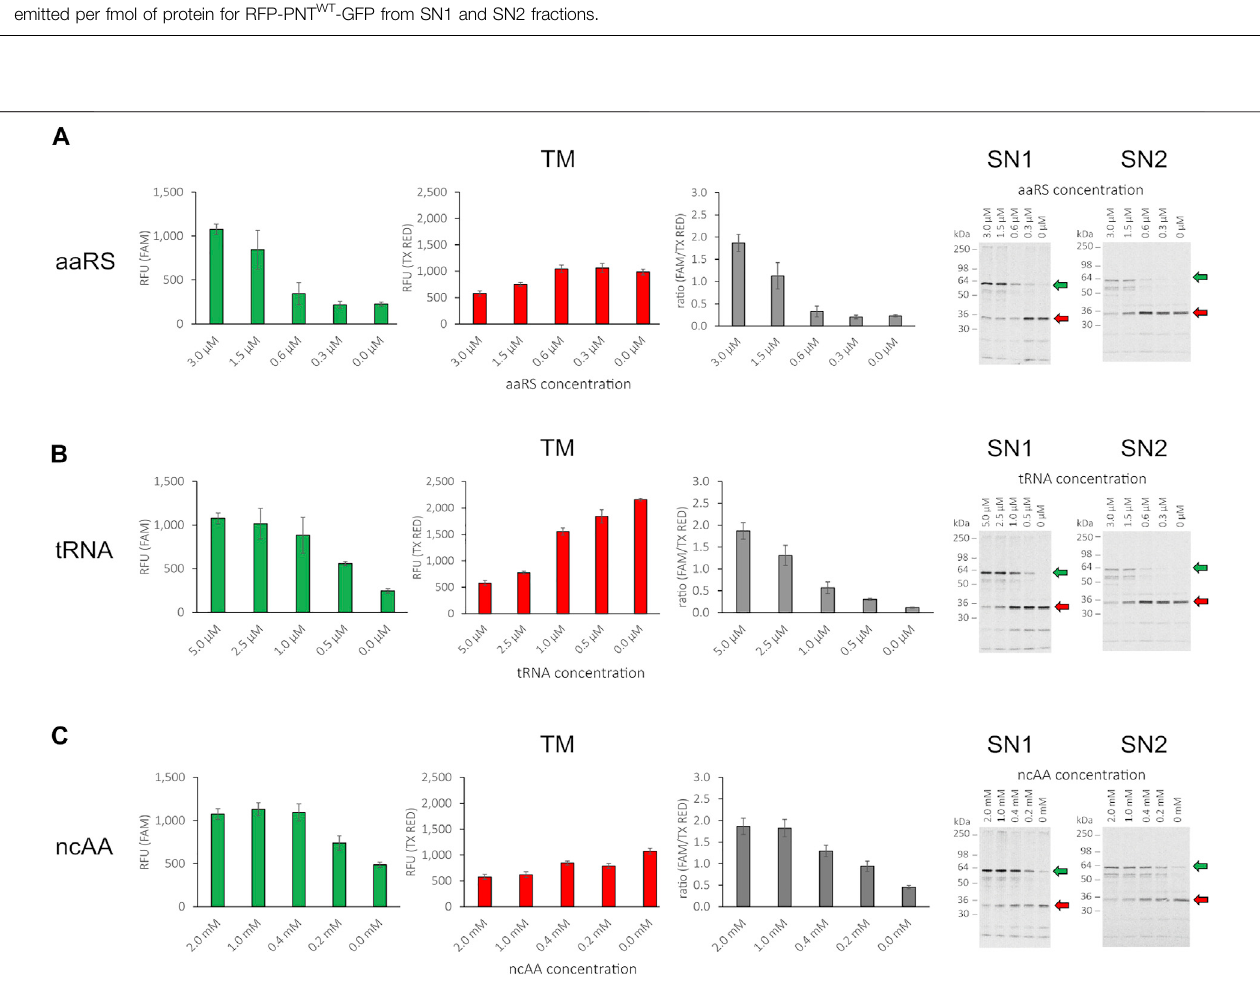
FIGURE 4 | In fl uence of orthogonal component concentration on fl uorescence of RFP-X-GFP reporter protein in the translation mix (TM) and SDS-PAGE of correspondingsupernatantfractions SN1 and SN2. (A) Variation ofaaRS concentration with5 µM tRNA and 2 mM ncAA, (B) variationoftRNA concentrationwith3 µM aaRS and 2 mMncAA, (C) variationofncAAconcentrationwith3 µMaaRS and 5 µMtRNA forthetranslationmix(TM)intheFAMchannel,theTexas Redchannel, ratio of RFU (FAM/TX Red), and the corresponding visualization of the SN1 and SN2 fraction in a radiography of 10% SDS-PAGE (from left to right). Mean values of triplicates were background fl uorescence subtracted and are plotted with error bars representing their standard deviation. Green and red arrows depict the full length protein and the termination product, respectively.